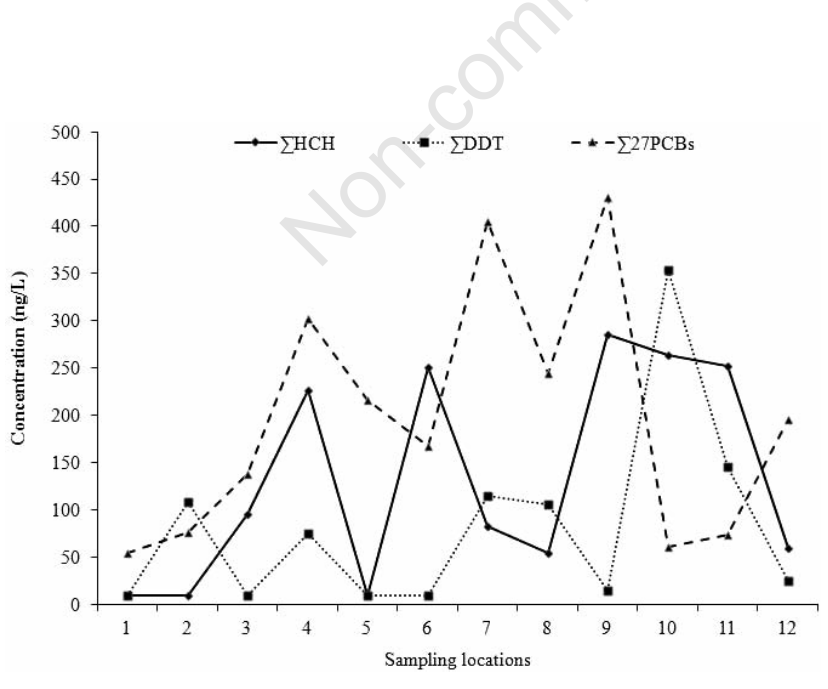
Figure 3. Station-wise distribution of total hexachlorocyclohexane, dichlorodiphenyl- trichloroethane and polychlorinated biphenyls in Yamuna River water.